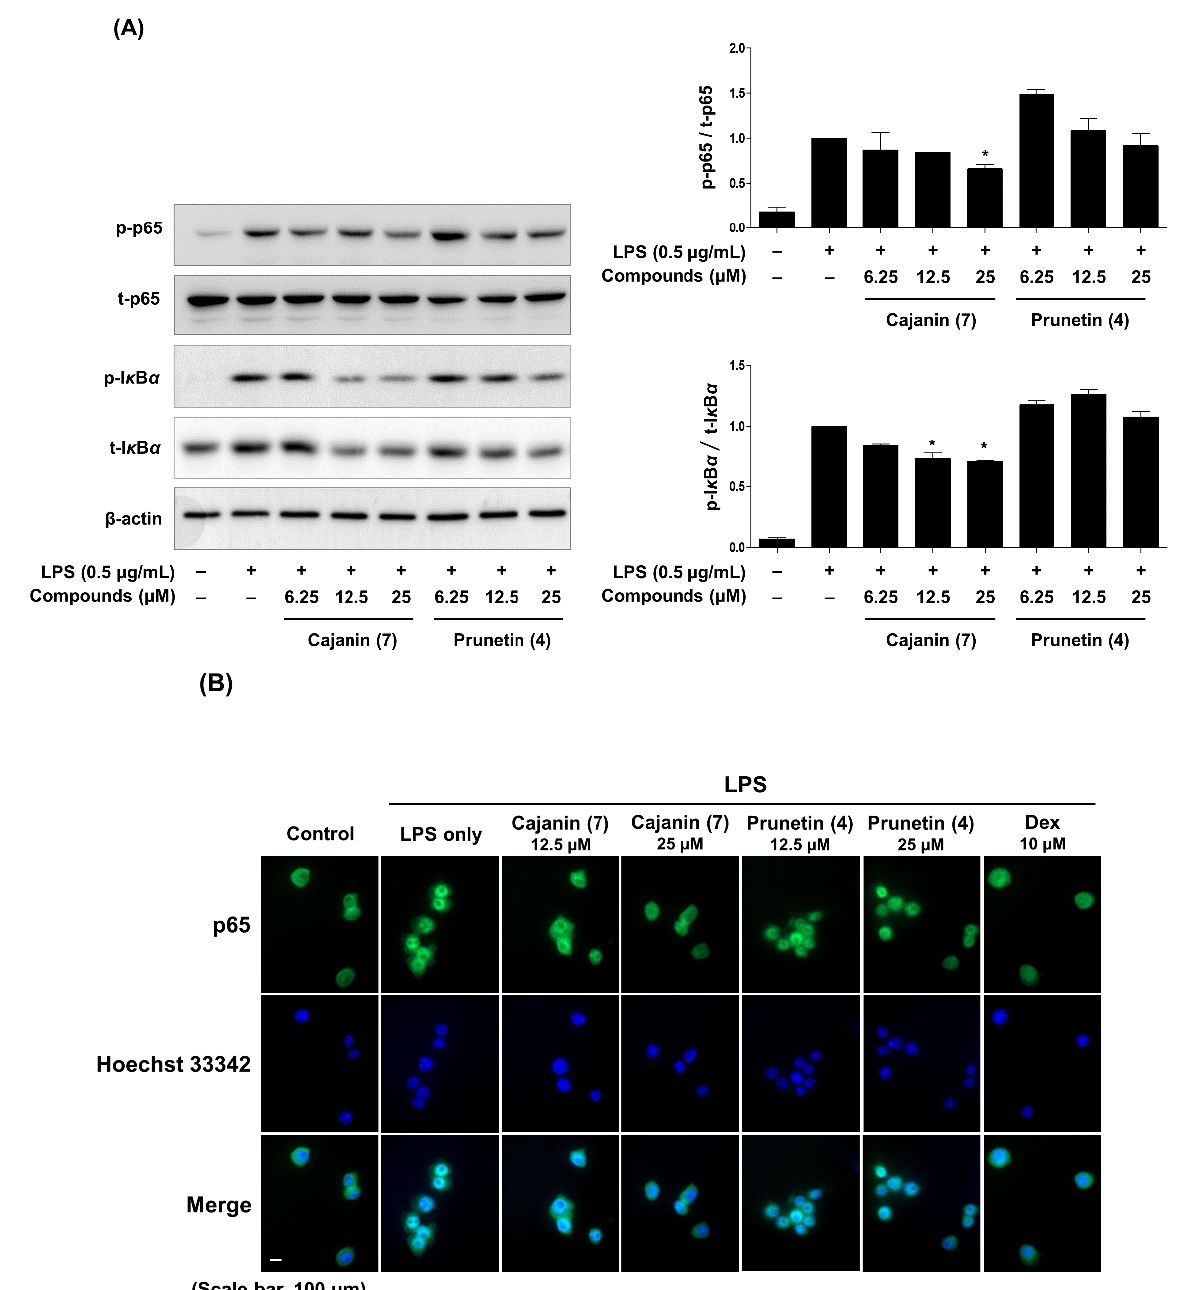
Figure 5. Effect of prunetin ( 4 ) and cajanin ( 7 ) on the phosphorylation of NF- κ B (p65) and I κ B α and nuclear translocation of NF- κ B (p65) in LPS-induced macrophage cells. ( A ) Whole-cell lysates were prepared from RAW264.7 cells treated with or without LPS (0.5 µ g/mL) and were subjected to Western blot analysis to investigate the phosphorylation of NF- κ B (p65) and I κ B α . The band intensities of phosphorylation of I κ B α (p-I κ B α ) and NF- κ B (p-p65) are represented as fold-change values using ImageJ software compared to total-I κ B α (t-I κ B α ) and total-p65 (t-p65), which was used as a loading control. Data are indicated as the mean ± SEM of three independent experiments. Significant differences are expressed as asterisks between the LPS only and experimental groups (* p < 0.05). ( B ) Immunocytochemical analysis was performed to explore the nuclear localization of NF- κ B (p65) using the fluorescence of Alexa Fluor 488 and Hoechst 33342. Dexamethasone (Dex) served as a positive